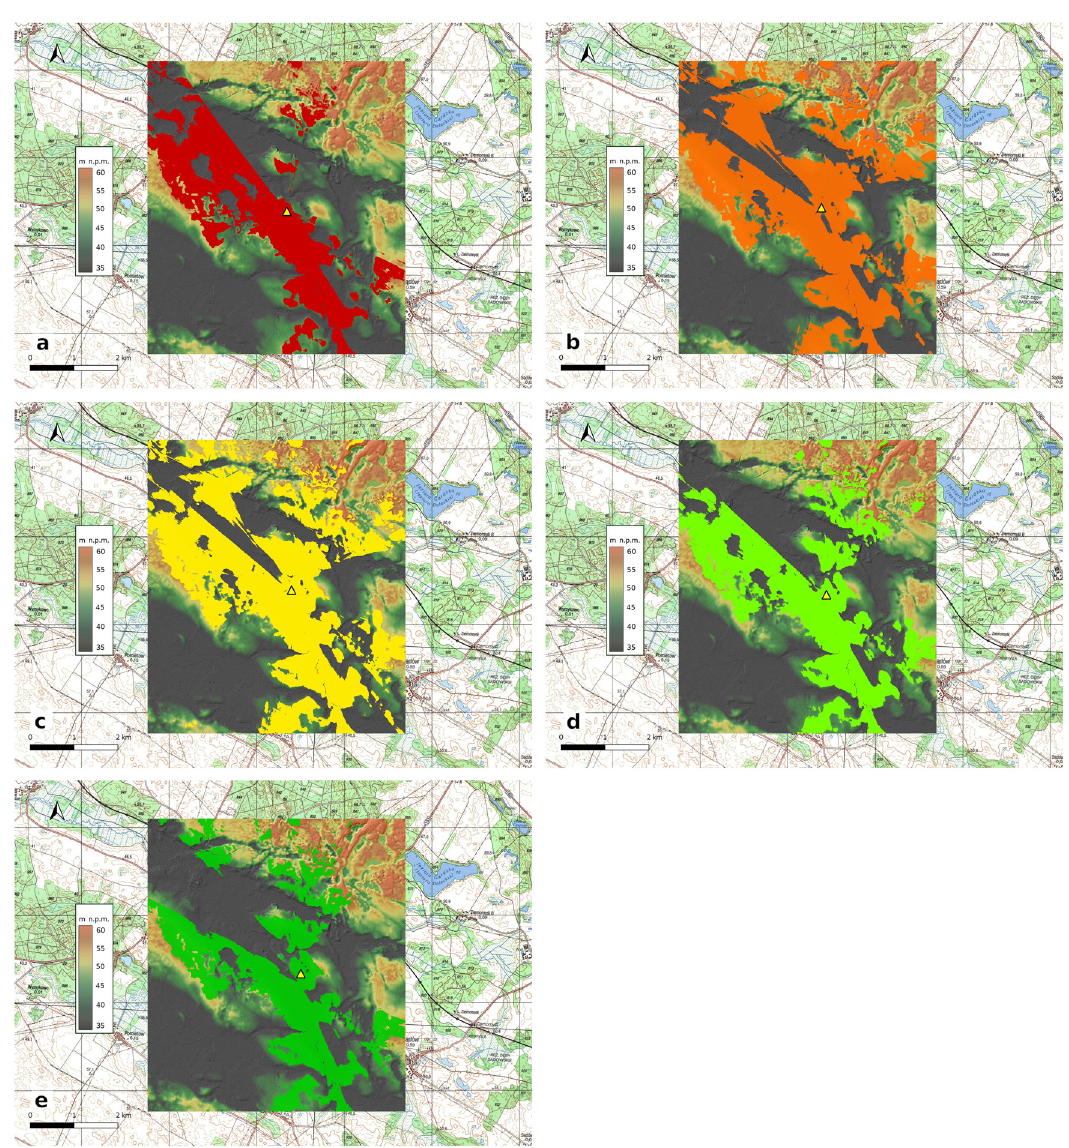
Figure 18: The Dolice - Komorowo South megalithic group. The area from which the tombs 9 ( a ) , 10 ( b ) , 11 ( c ) , 12 ( d ) , and 13 ( e ) are visible ( M. Schiller )